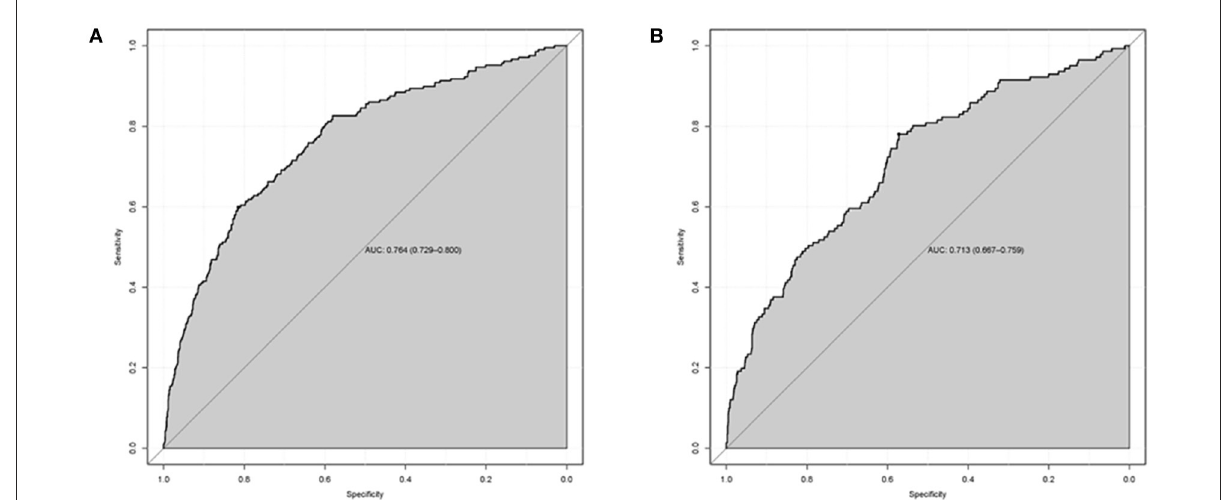
FIGURE6 The area under the receiver operating characteristic (ROC) curves (AUCs) of the nomogram for predicting 1-year all-cause mortality in CABG group (A) and Valvular surgery group (B) .